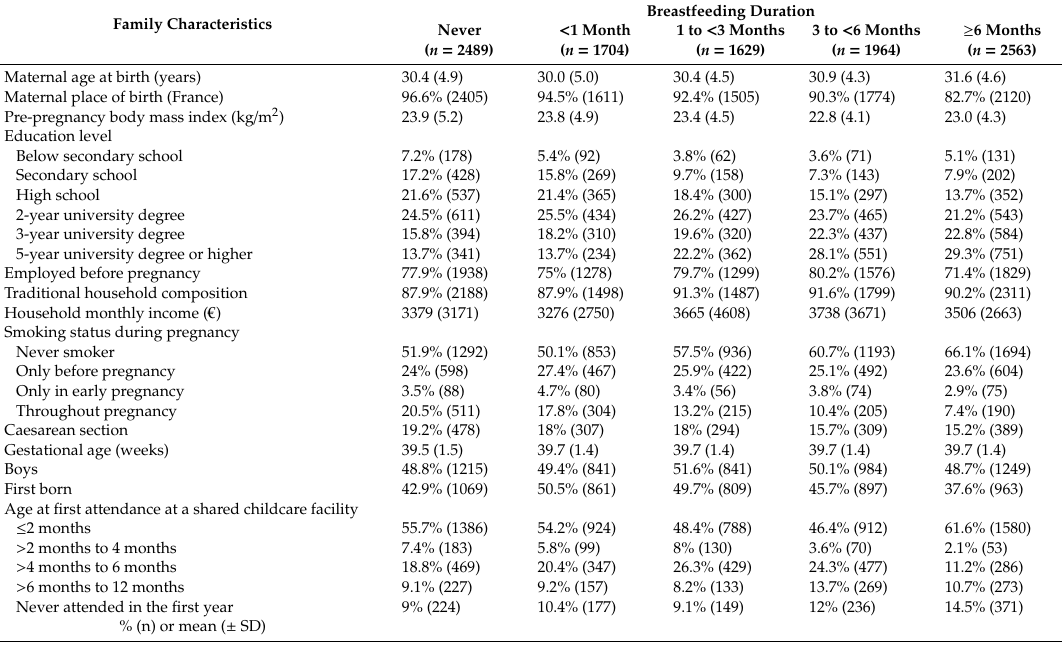
Table 1. Included families’ characteristics according to any breastfeeding duration ( n = 10,349). Family